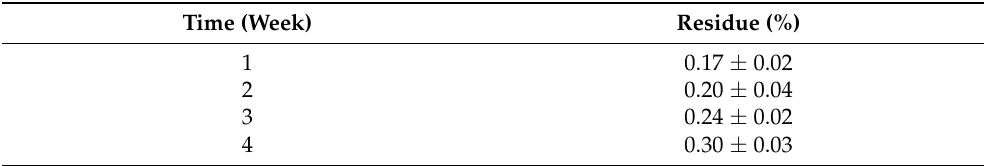
Table 1. Residue values (%) over four weeks evaluated from the supernatant liquid